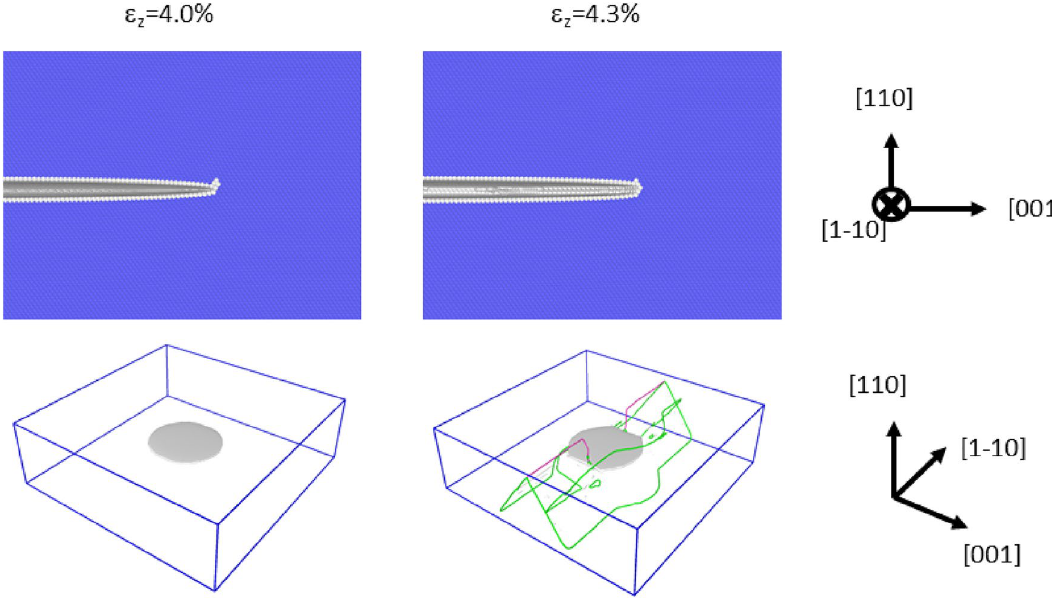
Figure 4. The initial condition of the {110} cleavage simulation and the snapshot after imposing 0.3% mode-I tensile strain. The upper diagrams show the cross sections in the vicinity of the crack front. The common neighbor analysis was used for determining the atomic color. The bottom diagrams show the cracked surfaces (in grey) and dislocations emitted from the crack front. The green and red lines denote 1/2<111> and <100> dislocations, respectively. Although some dislocations exist in the bottom right diagram, no lattice defect is seen in the top right diagram, because the top diagrams are magnified and shows only the vicinity of the crack tip.